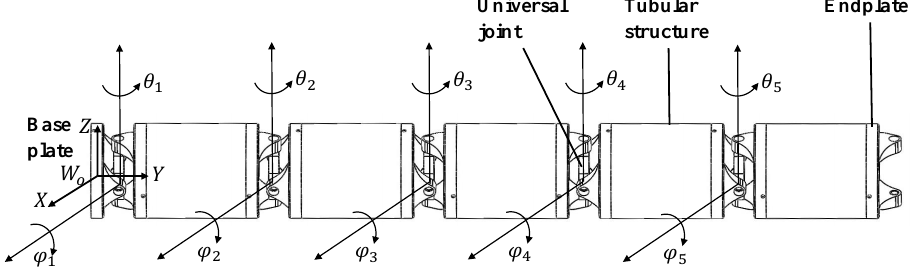
Figure 3. The world coordinate system and joint angles